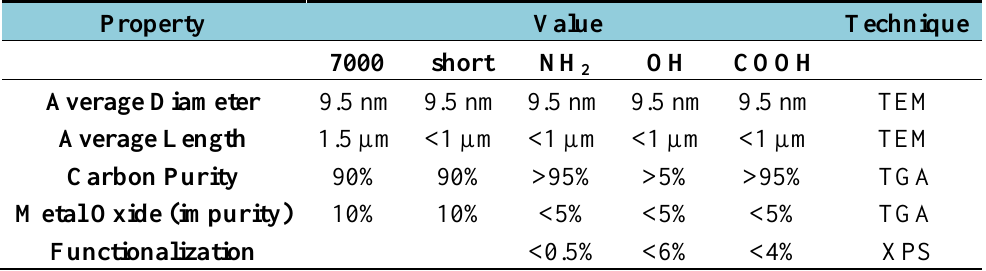
Table 1. Carbon nanotube (CNT) characteristics. XPS, X-ray photoemission spectrometry.